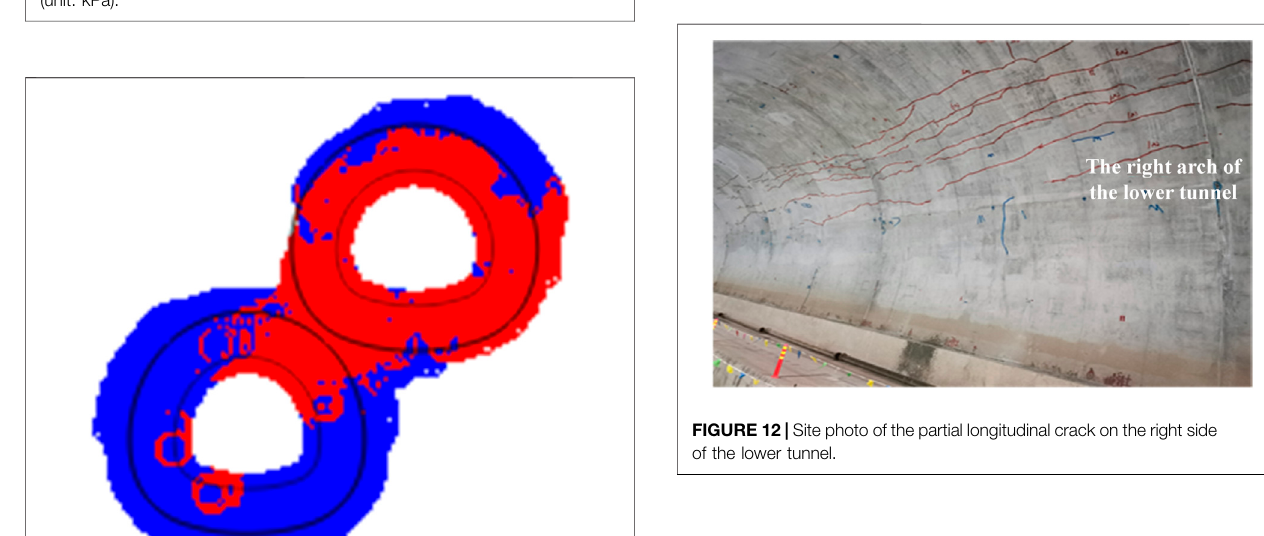
FIGURE 9 | Maximum shear stress after excavation of the upper tunnel (unit: kPa).